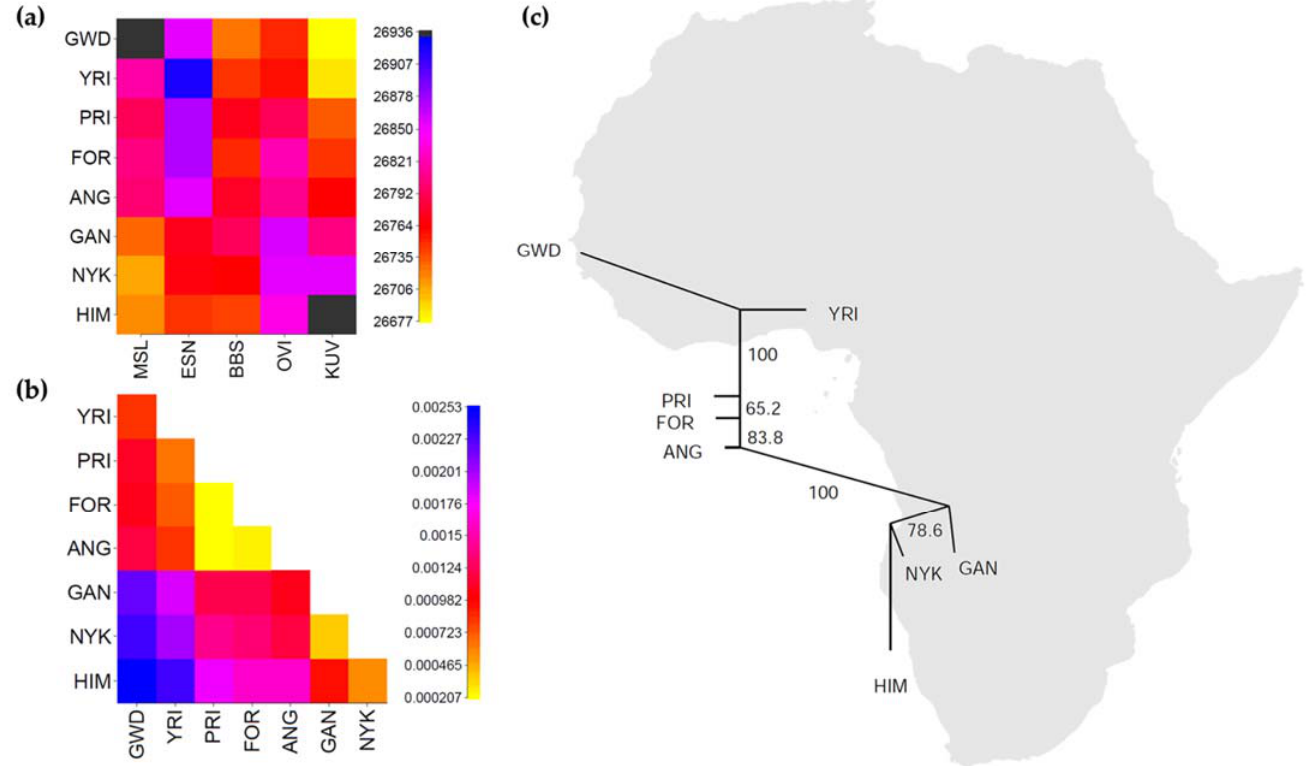
Figure 2. Ancestry inference in the studied populations. ( a ) CHROMOPAINTER coancestry matrix based on the number of haplotype segments (chromosome chunks) shared between donor (columns) and recipient (rows) populations. The copy profile of each recipient group is an average of the copy profiles of all individuals belonging to that group. ( b ) Matrix of pairwise TVDxy distances based on the ancestral profiles of the recipient groups in panel ( a ). The scales of chunk counts and TVDxy values are shown to the right of the matrices. ( c ) Neighbor ‐ Joining (NJ) tree based on TVDxy distances. Values indicate the percentage of NJ partitions observed in 1000 replicas of the coancestry matrix, generated by sampling the individual copy profiles from each population with replacement. The NJ tree was rotated to fit the approximate geographic location of the recipient groups. Abbreviations: GWD (Mandinka), MSL (Mende), ESN (Esan), YRI (Yoruba), ANG (Angolares), BBS (Bubi), FOR (Forros), PRI (Principenses), GAN (Ganguela), HIM (Himba), KUV (Kuvale), NYK (Nyaneka), OVI (Ovimbundu).